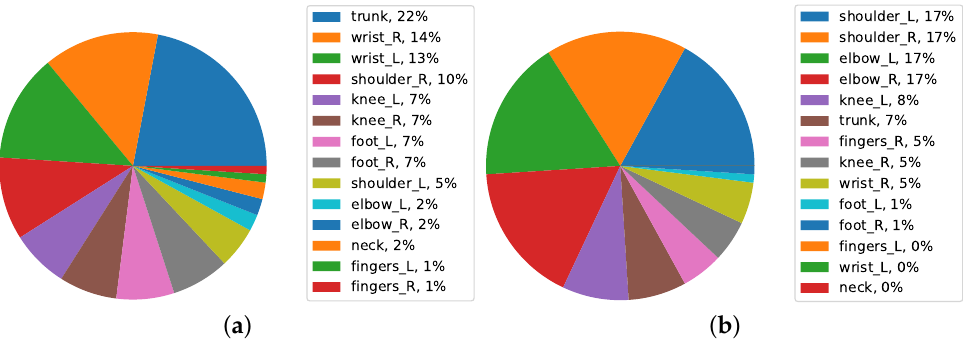
Figure 16. Average FWA of body parts in Paint ( a ) and ( b ) Quality Assurance